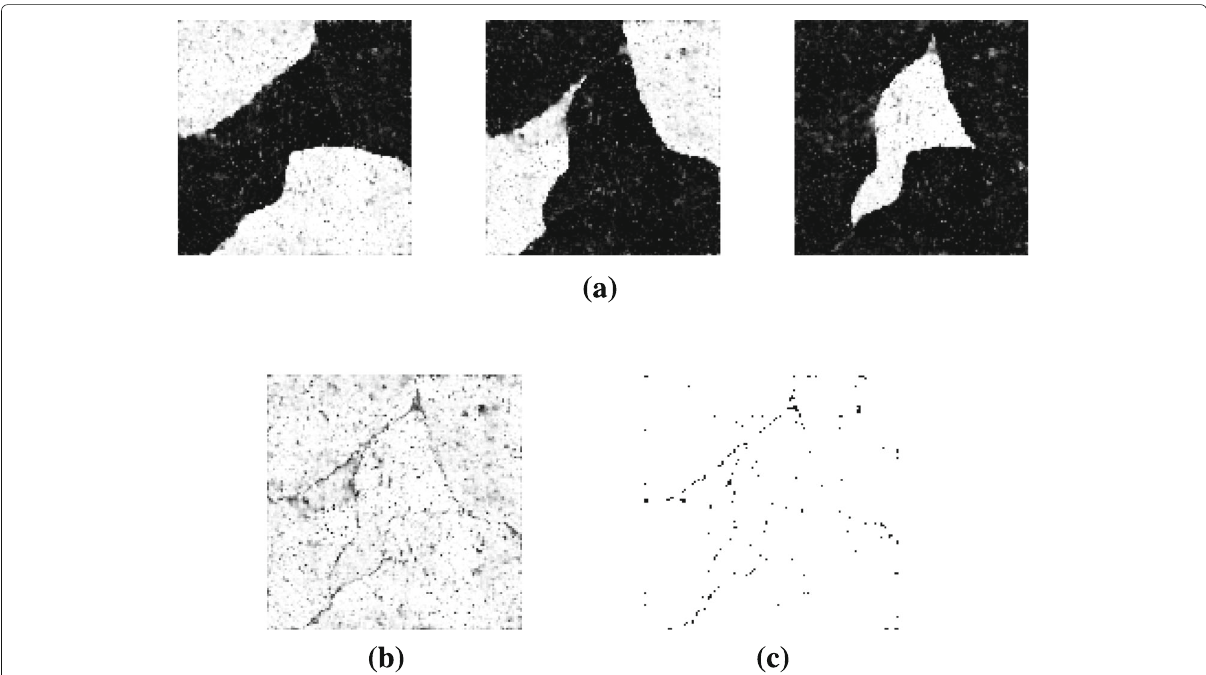
Fig. 5 Link between the probability of the selected label and the labelling error. a From left to right: probability for each pixel of having label 1, 2 or 3, respectively (black is zero and white is one). b Probabilities. c